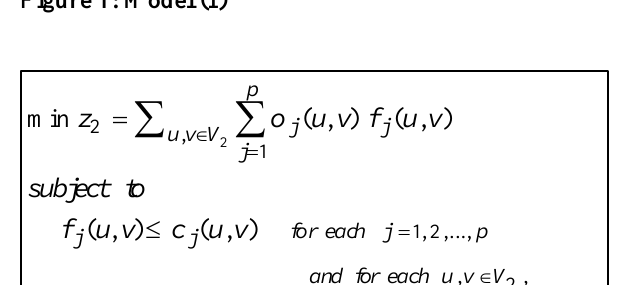
Figure 1: Model (I)